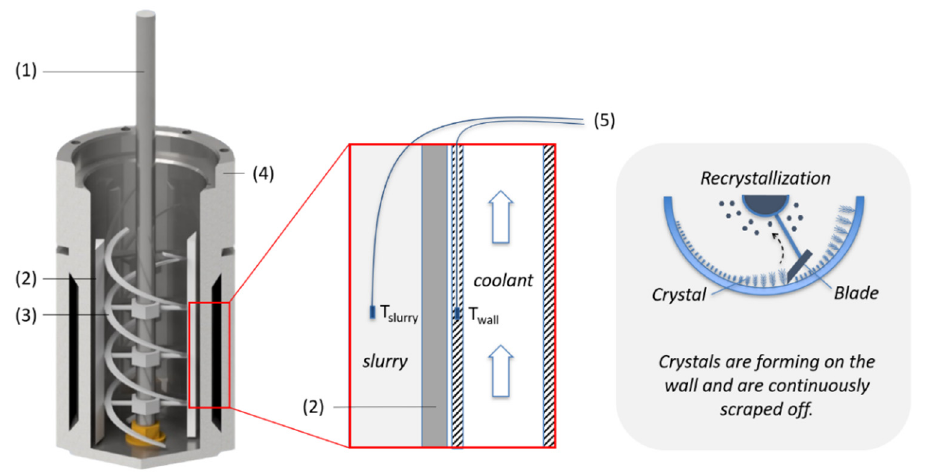
Figure 2. Left: Design of the scraped surface heat exchanger: (1) spindle, (2) blade, (3) double helix mixer, (4) scraped surface heat exchanger and (5) thermocouples to measure wall and slurry temperature. Right: Schematic sketch showing how crystals are scraped off the cold wall by the blade.